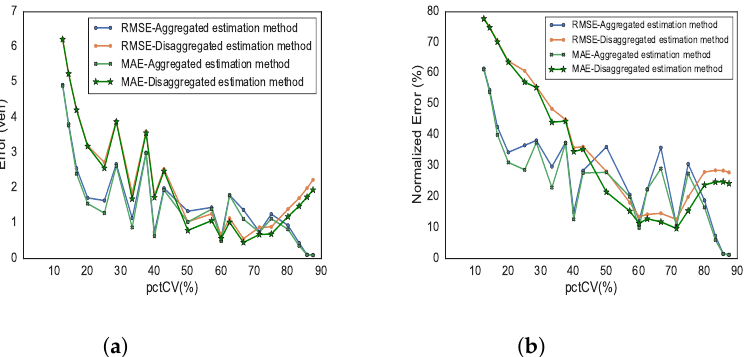
Figure 12. Accuracy measure of estimated total vehicle counts based on the pctCV of CVs ( a ) RMSE and MAE ( b ) NRMSE and NMAE.